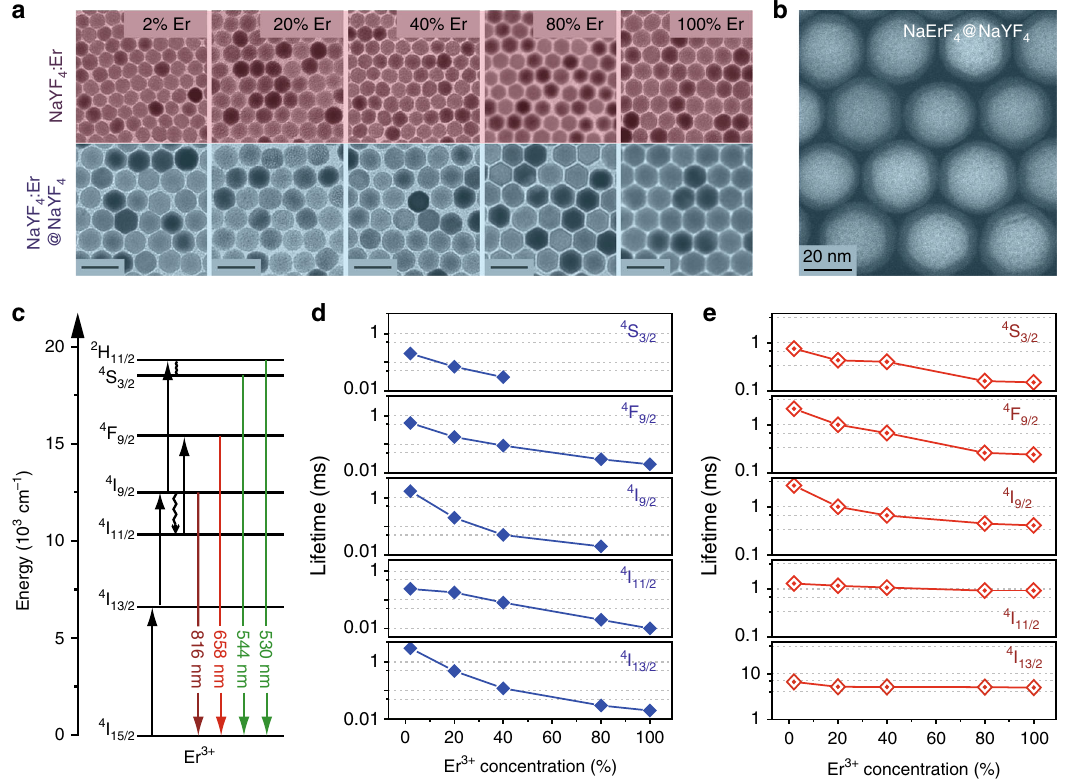
Fig. 2 Comparative characterization of the NaYF 4 :Er and NaYF 4 :Er@NaYF 4 nanocrystals. a TEM images of the NaYF 4 :Er (2 − 100%) core and the NaYF 4 :Er (2 − 100%)@NaYF 4 core − shell nanocrystals. Scale bars are 50 nm. b HAADF scanning TEM image of the NaErF 4 @NaYF 4 nanoparticle highlighting the core − shell structure. c Proposed energy diagram showing upconversion processes in Er 3 + under 1532 nm excitation. The full, wavy, and colored arrows represent excitation, multiphonon relaxation, and emission processes, respectively. d , e Lifetimes of various excited states of Er 3 + as a function of the dopant concentration in the NaYF 4 :Er (2 − 100%) core and the NaYF 4 :Er (2 − 100%)@NaYF 4 core − shell nanoparticles, respectively. The excitation pulse energy density was set at 1 mJ mm − 2 for decay